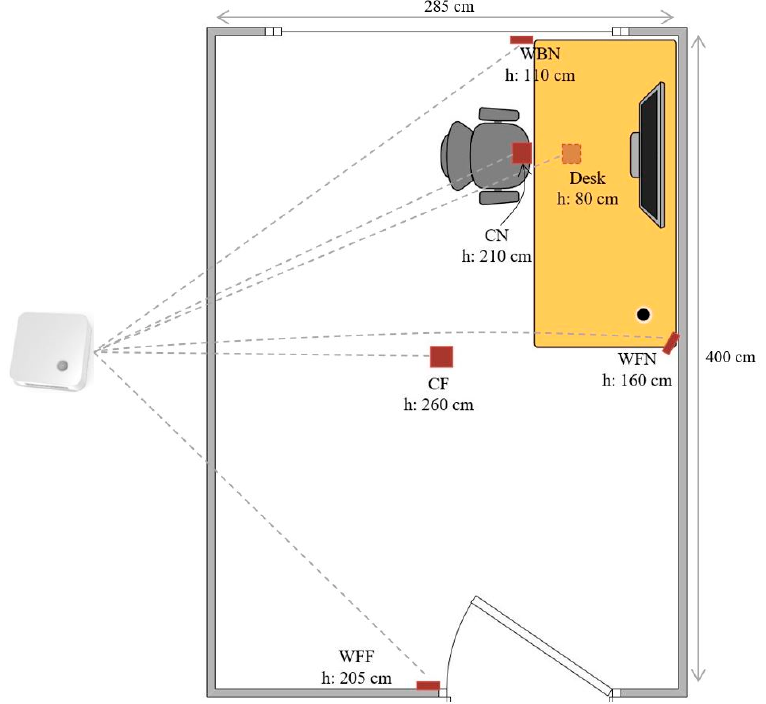
Figure 2. Schematic layout of one of the offices and sensor positionings (“h” stands for the height that the sensor installed).